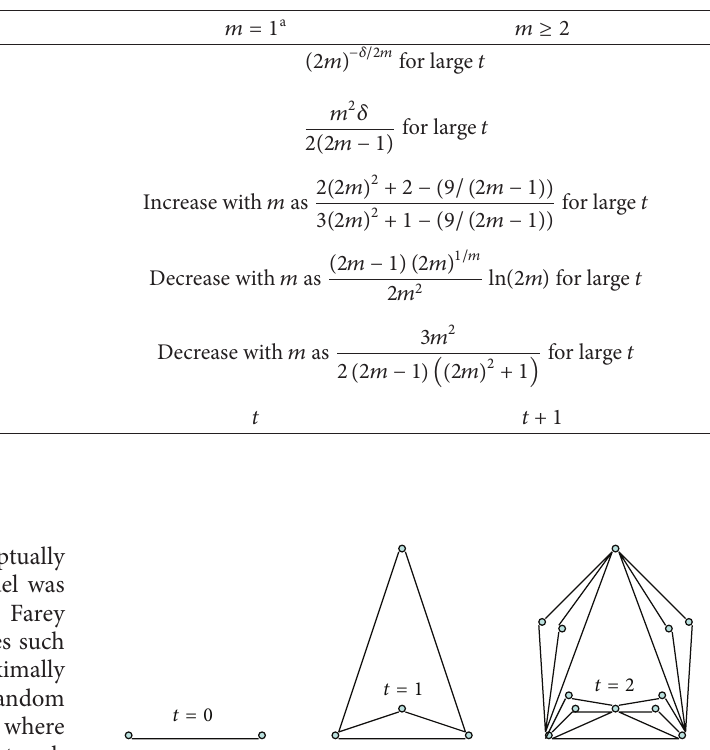
Table 1: Properties of model 𝐺(𝑚,𝑡) .